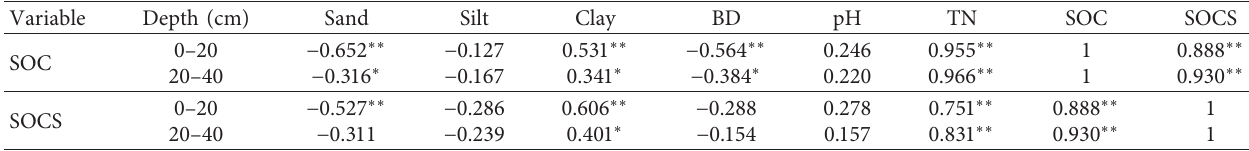
Table 4: Correlation between SOC and SOCS with the selected soil physicochemical properties at the two depths. Variable